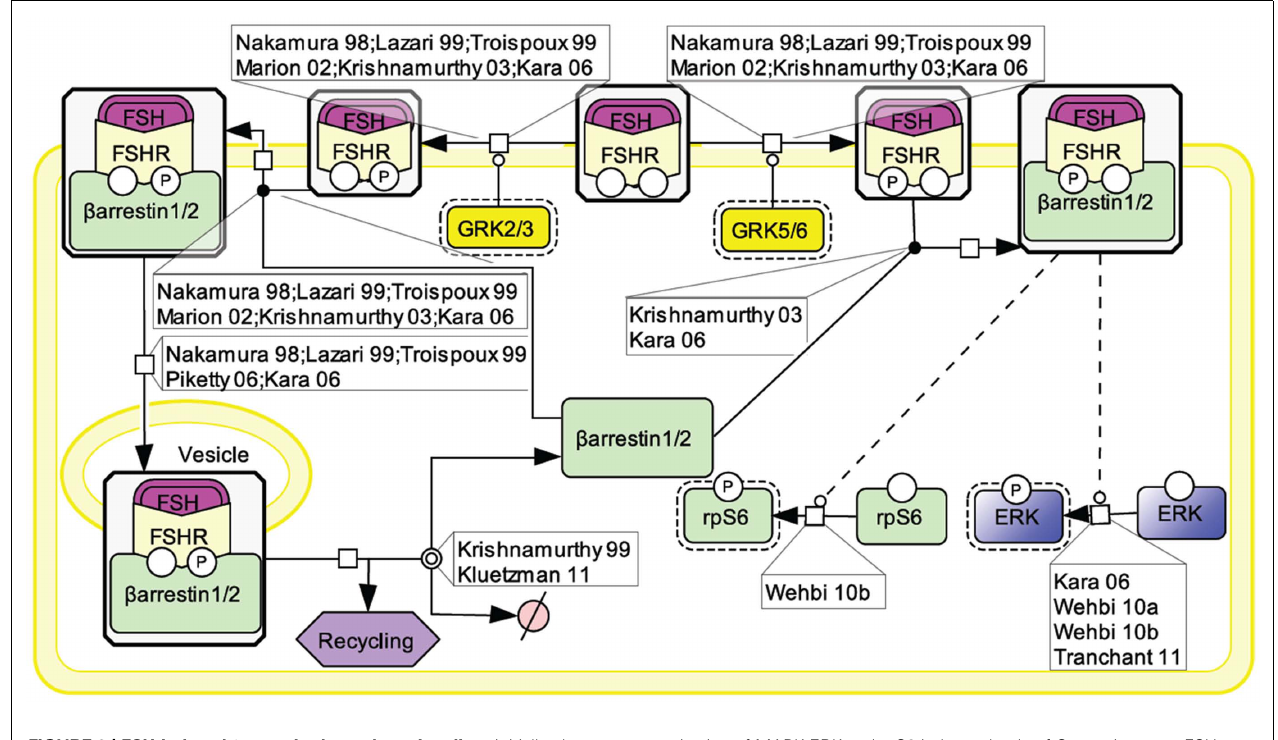
FIGURE 3 | FSH-induced β -arrestin-dependent signaling. Initially, the perception of β -arrestins’ role was restricted to the control of FSHR’s desensitization and recycling.This view has progressively evolved toward a more general role of β -arrestins as adapters and transducers leading to the